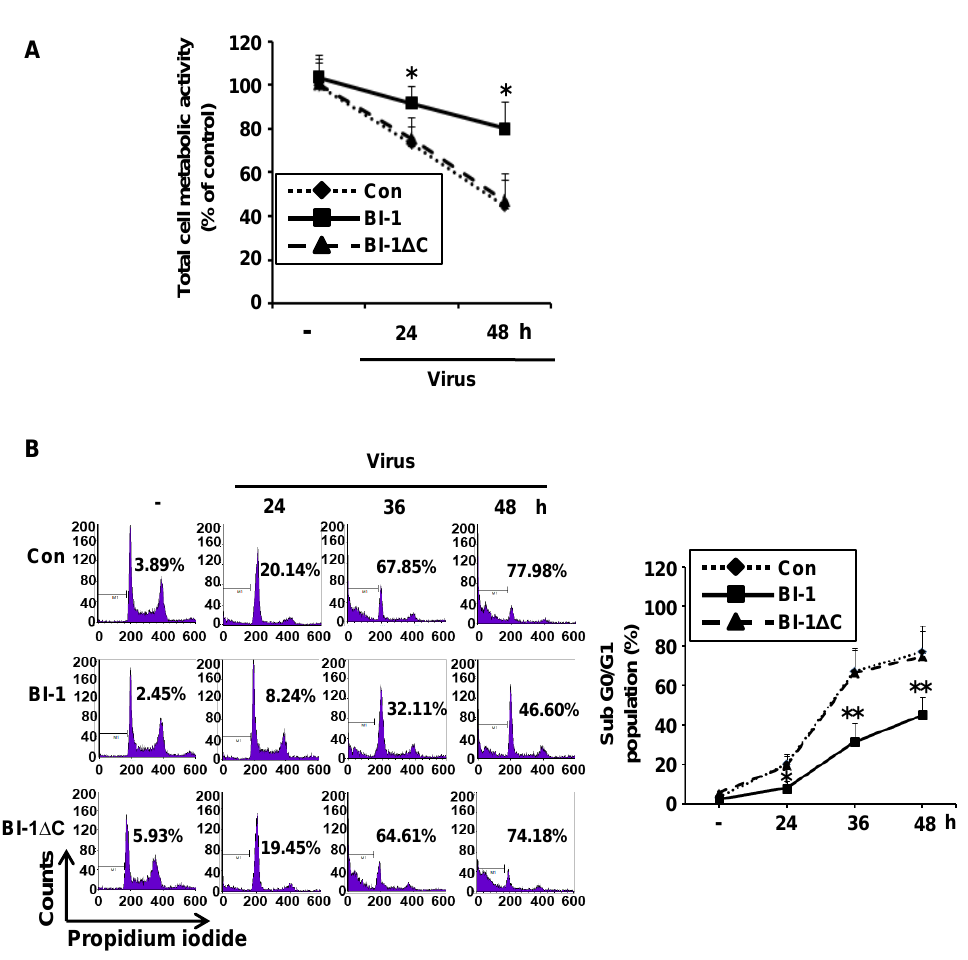
Figure 2. Overexpression of Bax inhibitor-1 ( BI-1 ) inhibits virus induced cell death and cell cycle arrest in MDCK cells. ( A ) Control mock-infected MDCK, BI-1 -overexpressing MDCK, and BI-1 ∆ C-overexpressing MDCK cells were seeded in 96-well cell culture plates and infected with A/PR/8/34 virus at 100 TCID 50 . The media were changed 2 h after virus infection, and MTT assays were performed 24 h and 48 h after virus infection. Data were shown as the relative expression of cell metabolic activity of BI-1 -overexpressing MDCK, and BI-1 ∆ C-overexpressing MDCK cells compared to the control infection from three individual experiments (mean ± SEM) (* p < 0.05). ( B ) Control MDCK, BI-1 -overexpressing MDCK, and BI-1 ∆ C-overexpressing MDCK cells were seeded in 6-well cell culture plates and infected with A/PR/8/34 virus at 1000 TCID 50 . Anti-influenza activity was determined three times calculating the apoptotic sub-G0/G1 populations by flow cytometric analysis 24 h, 36 h, and 48 h after virus infection. Data were expressed as relative numbers of apoptotic sub-G0/G1 populations of BI-1 -overexpressing MDCK, and BI-1 ∆ C-overexpressing MDCK cells compared to the control (mean ± SEM) (* p < 0.05, ** p <